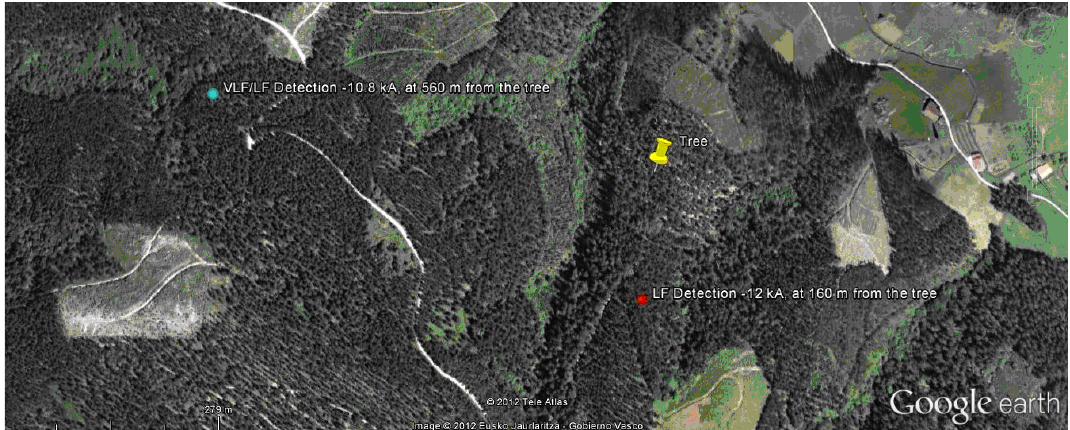
Fig. 3. Location of the lightning discharge that caused the accident as it was located compared to the two